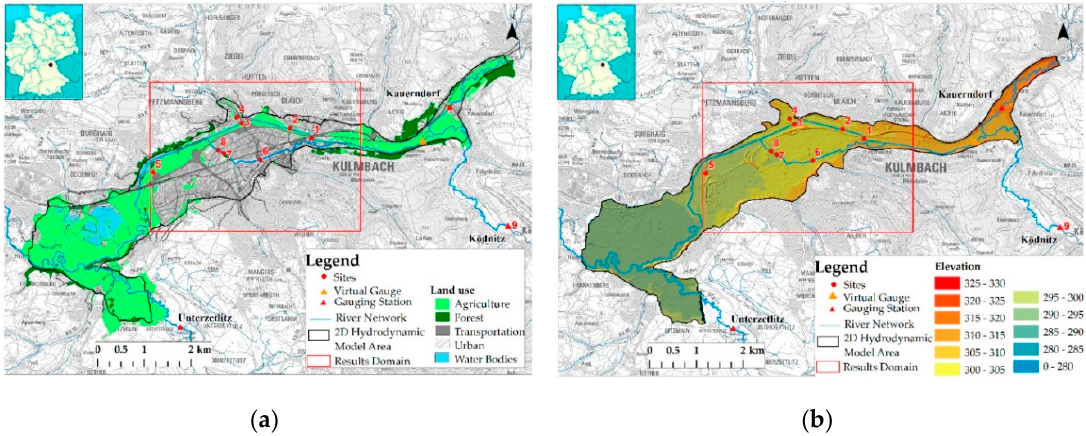
Figure 3. Land Use ( a ) and Terrain elevation ( b ) of the study area around Kulmbach from Bhola et al. (2018).